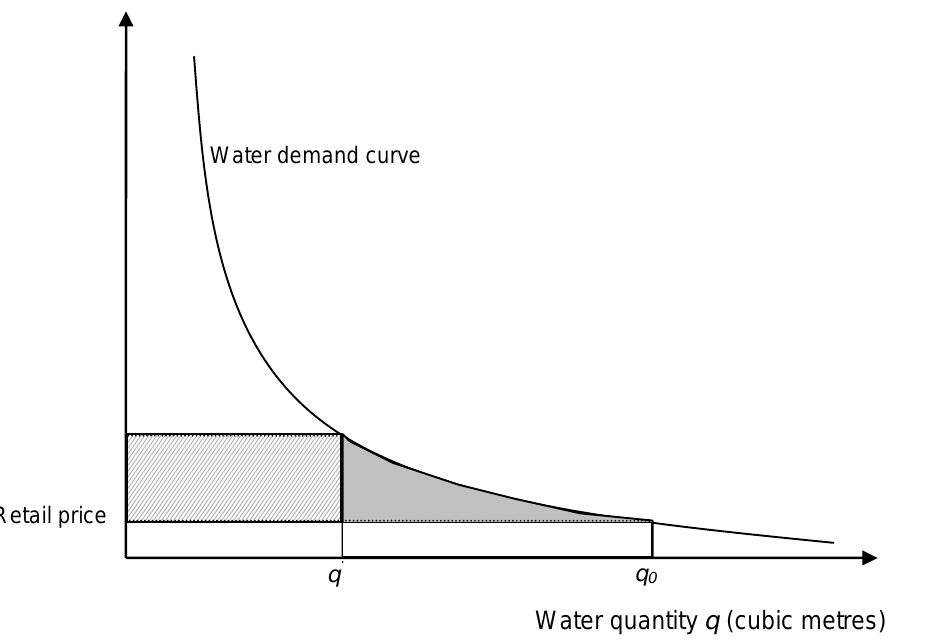
Figure 1. Illustration of economic losses associated with water shortage. q that would be consumed in the case of no shortages; q‘ = the quantity actually consumed. The shaded area corresponds to the loss of consumer surplus due to reduced water availability. The rectangle with the diagonal pattern to the left of the shaded area corresponds to the scarcity rent to be paid by consumers due to water shortages; however, since water is supplied by governmental authorities, this scarcity rent remains at state ownership and hence is not considered a social